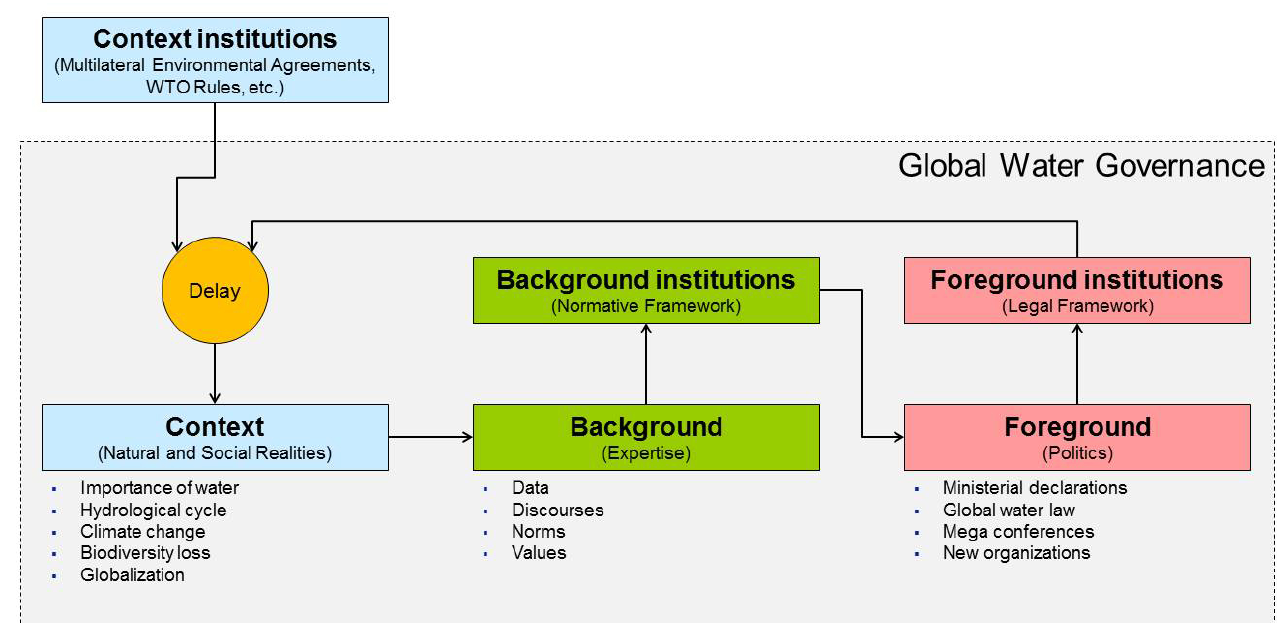
Fig. 1 . Interactions among the different GWG domains and their